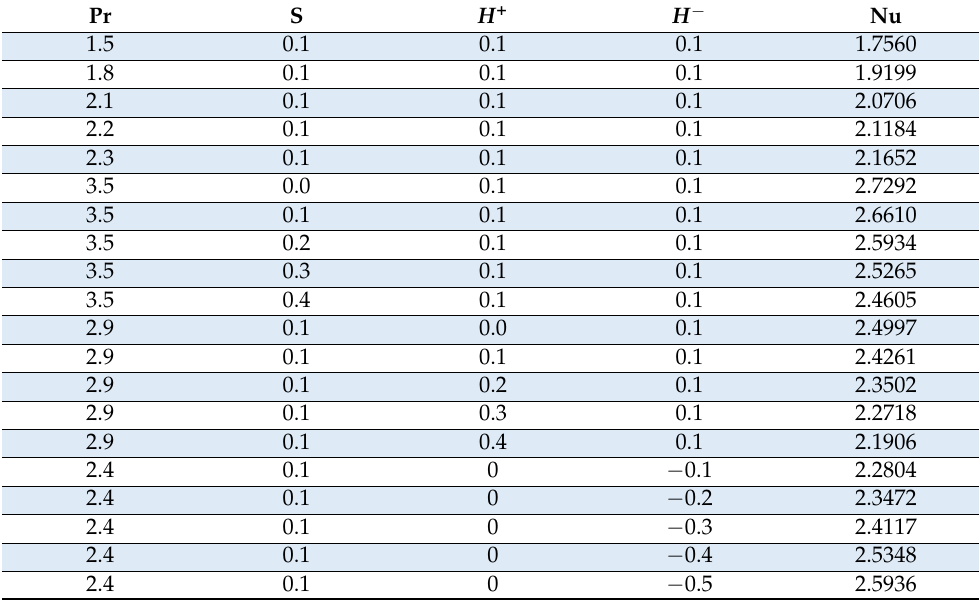
Table 4. Nusselt number variations subject to Flow